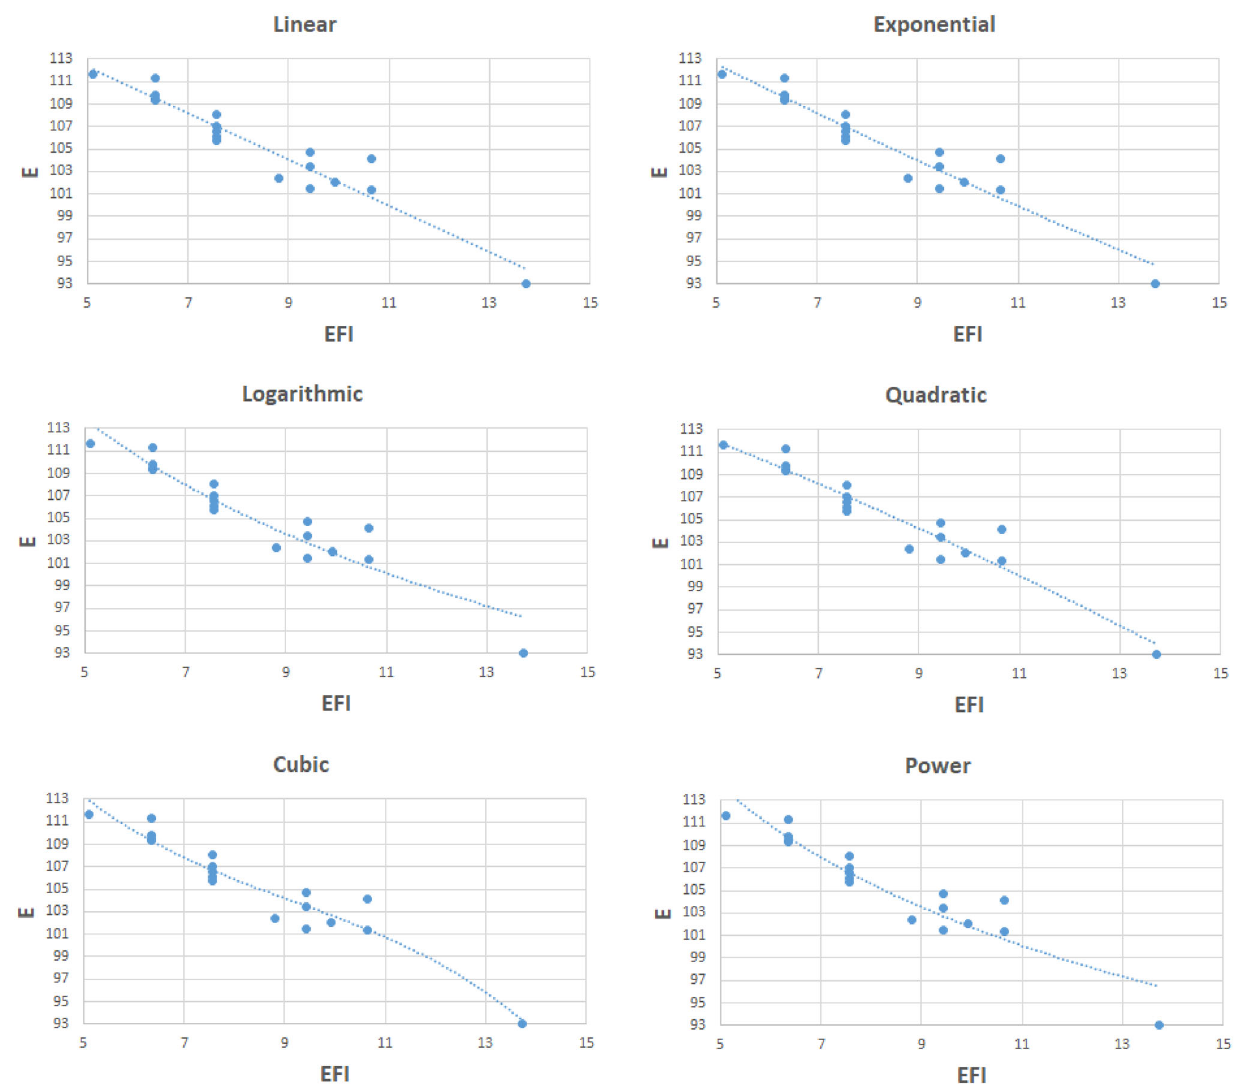
Fig. 5 The correlation of edge F-index with entropy for octane